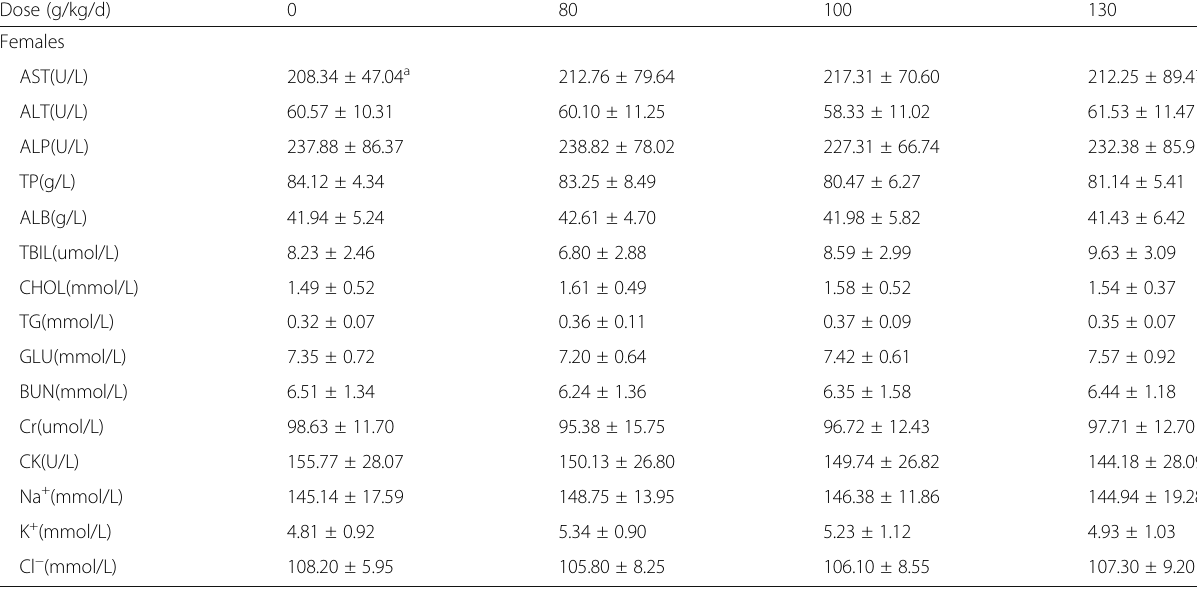
Table 9 Clinical chemistry data for female rats treated with JDHY granules for 13 weeks Dose